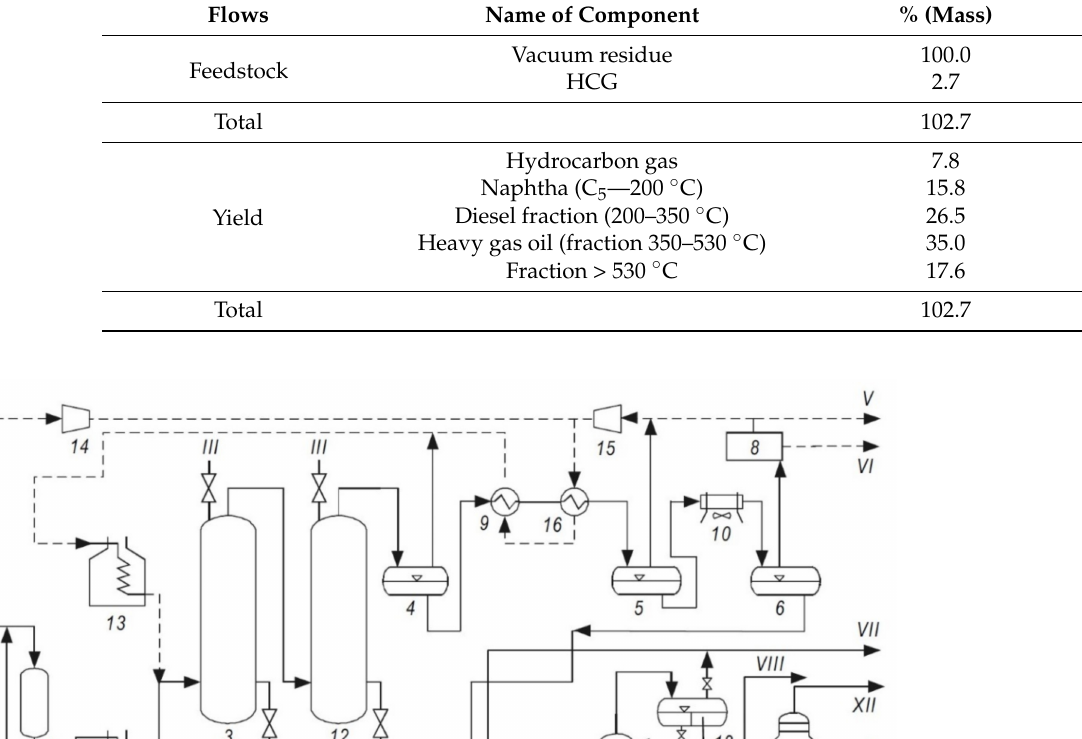
Table 1. Material balance of vacuum residue hydrocracking in a three-phase catalyst bed.